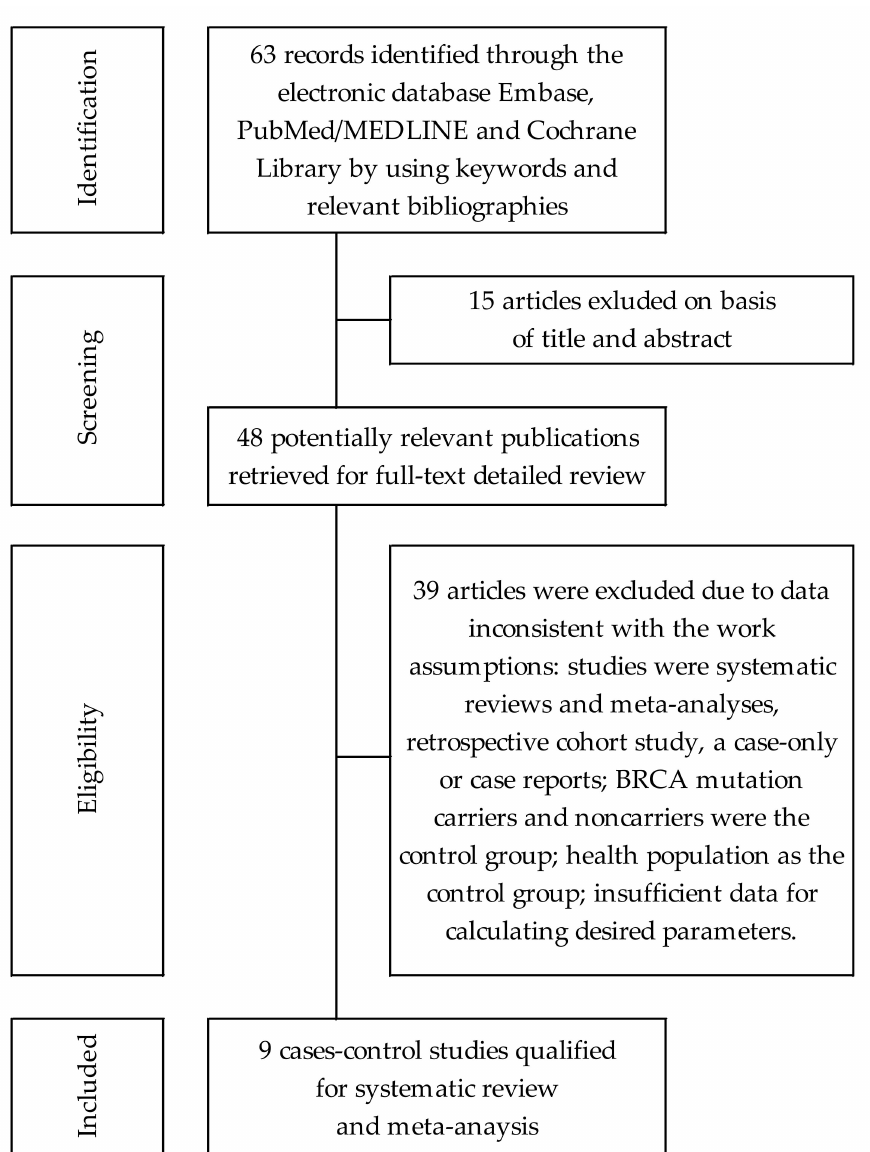
Figure 1. Flowchart of the selection procedure for studies included in the current review and meta-analysis. The included studies were published between 2002 and 2021. Data were pooled from nine case–control studies, comprising a total of 33,162 subjects, including 23,453 (70.7%) who had never used oral contraceptives (OCs). Characteristics of the included clinical trials are shown in Table 1. The group of cases (breast cancer) included 14,342 women, of which 9748 (68.0%) women were using OCs. For comparison, in the control group (unaffected BRCA mutation carriers), there were 18,820 women, including 13,705 (72.8%) women who used OCs. The studies provided data for BRCA1/2 mutation carriers (eight trials), BRCA1 mutation carriers (six trials), and BRCA2 mutation carriers (four